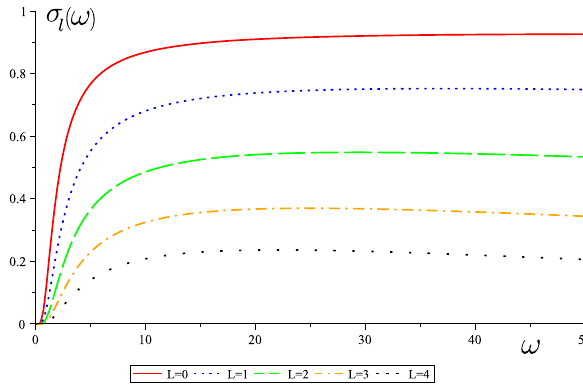
Fig. 4 Plots of σ l (ω) versus ω for the spin-0 particles. The physical parameters are chosen as; M = r = 1 , a = 0 . 03 and λ =